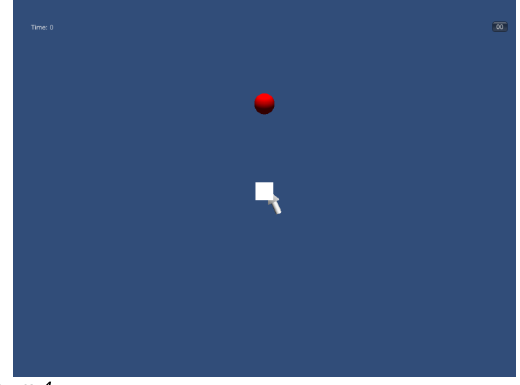
Tapping task with a 3D ball and cursor was developed in Unity. In the beginning, participants required to click the white cube in the centre, then a red ball (top) would appear.